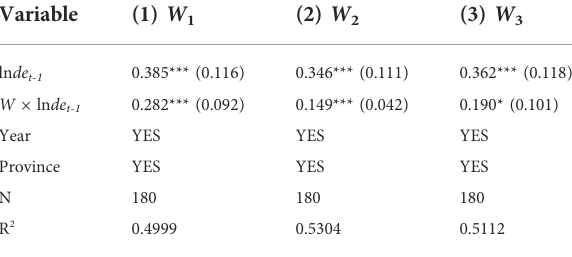
TABLE 8 Regression results of the lag